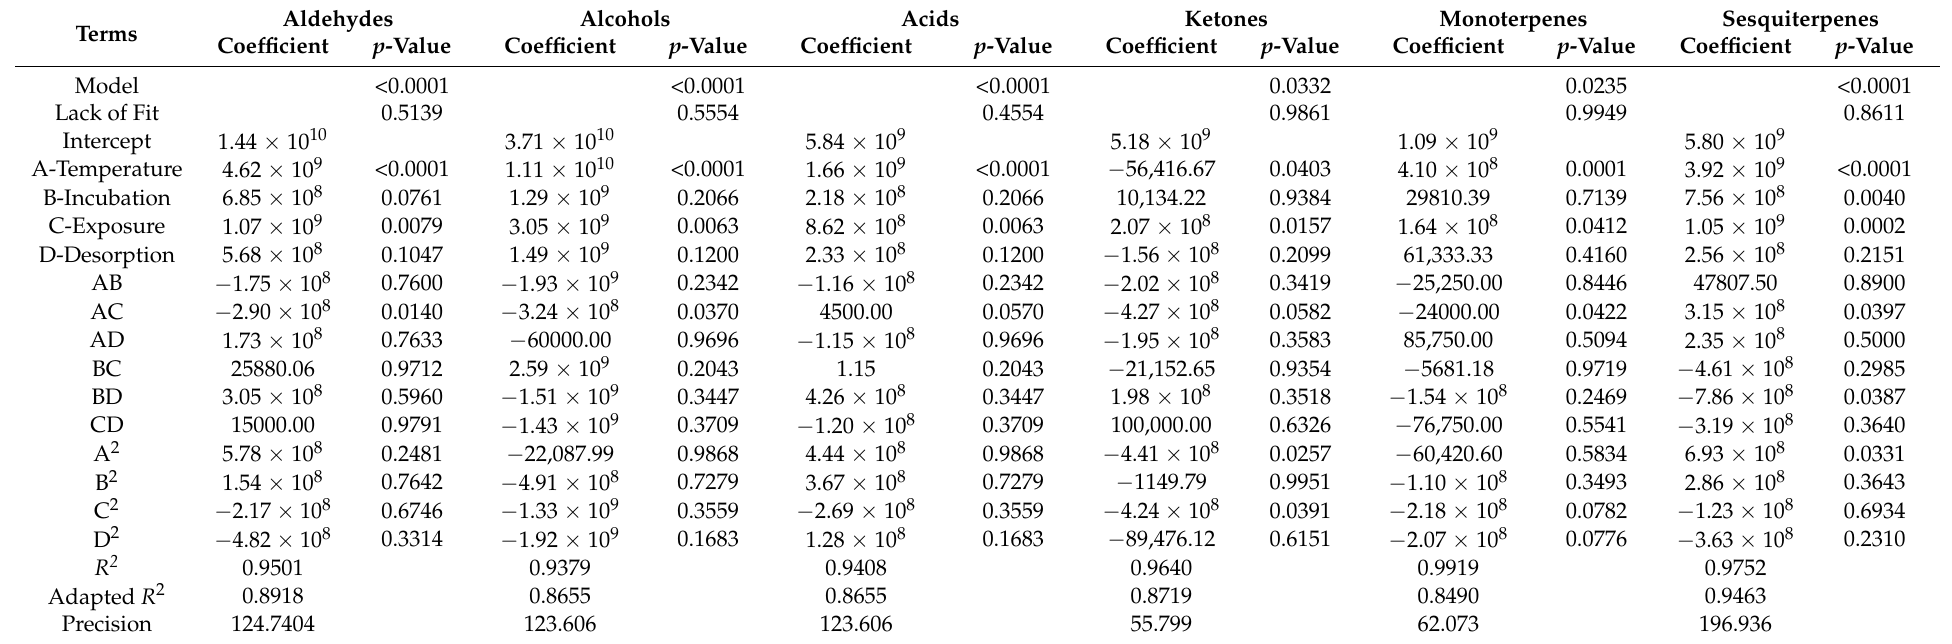
Table 1. Coefficients of the second order polynomial equation and regression coefficients of response and ANOVA parameters for obtained models for free